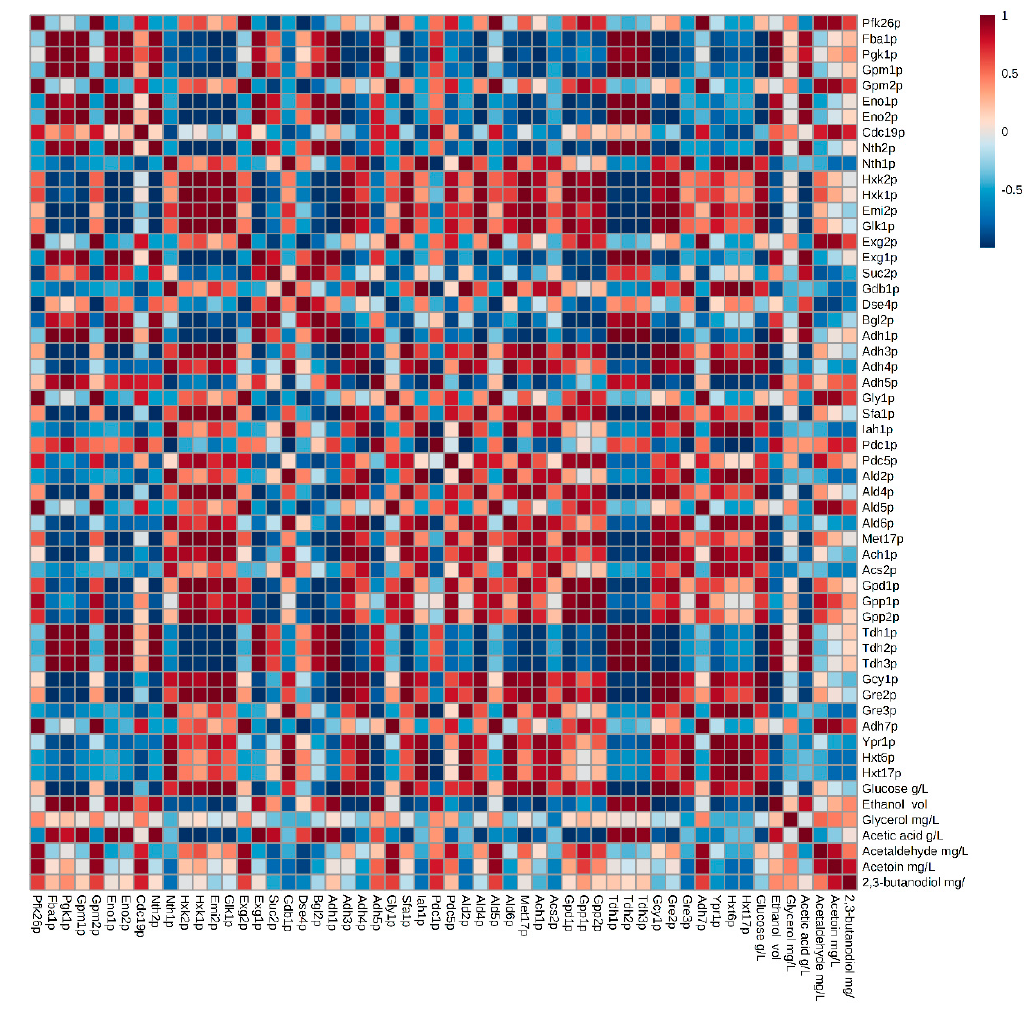
Figure 2. Matrix of correlations established between proteins and compounds released in the second fermentation in the flor yeast G1 strain. Metabolome data extracted from Martínez-García et al. (2020) [17].